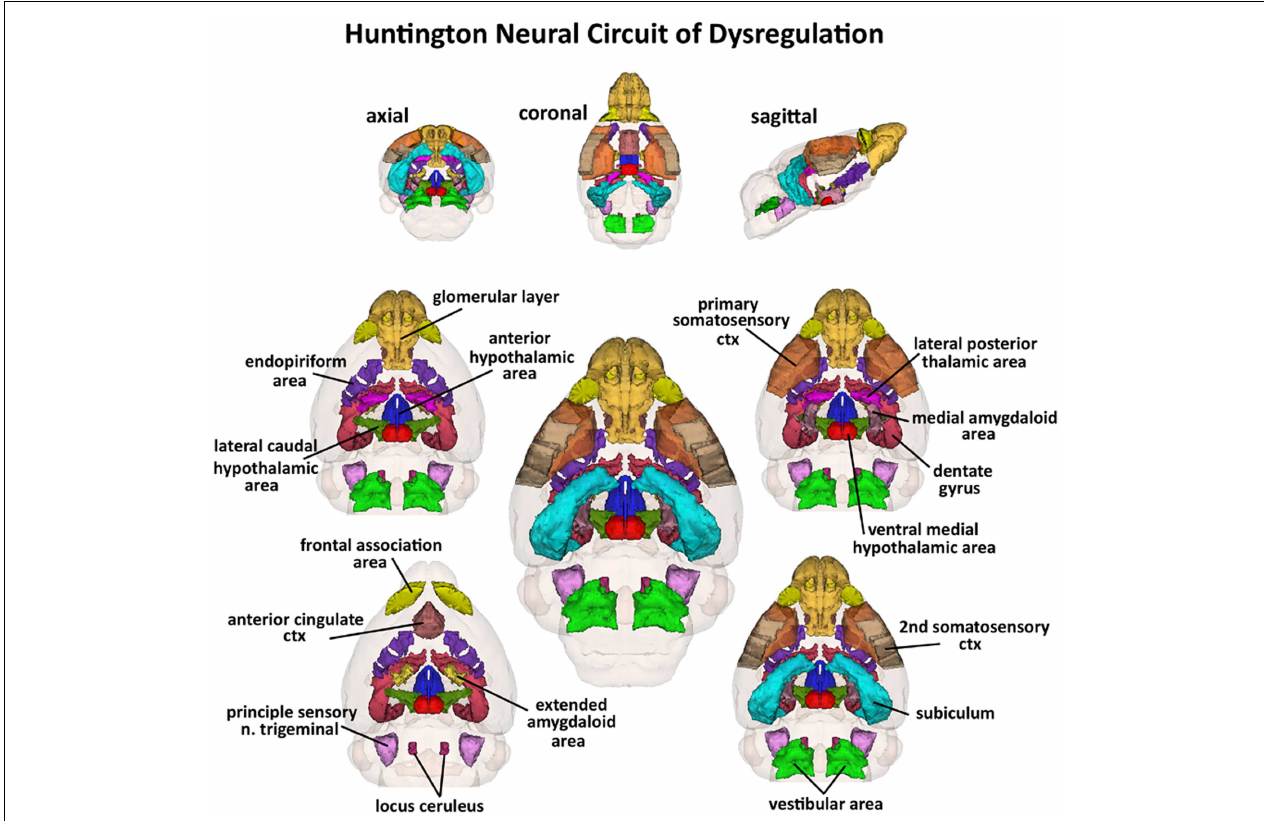
translucent shell of the brain showing the total composite and location of the different 3D volumes of interest. Surrounding this are different layers of the neural circuit showing a caudal (deepest) to dorsal perspective of the different brain volumes.The panels on the top show the neural circuit in different orthogonal